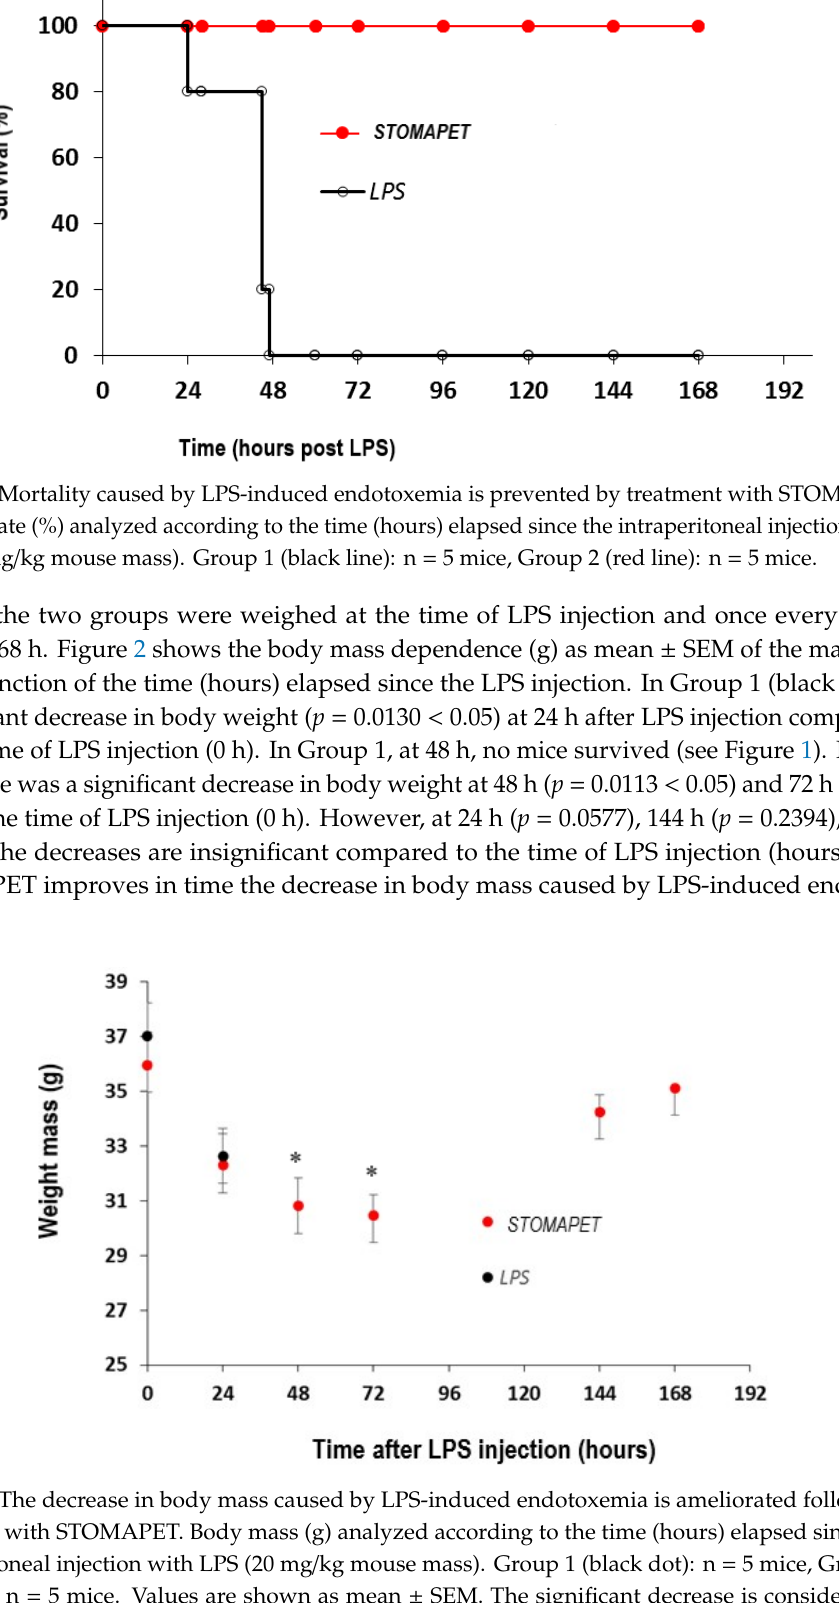
Figure 7. The decrease in body mass caused by LPS-induced endotoxemia is ameliorated following treatment with STOMAPET. Body mass (g) analyzed according to the time (hours) elapsed since the intraperitoneal injection with LPS (20 mg / kg mouse mass). Group 1 (black dot): n = 5 mice, Group 2 (red dot): n = 5 mice. Values are shown as mean ± SEM. The significant decrease is considered at p < 0.05 (*).